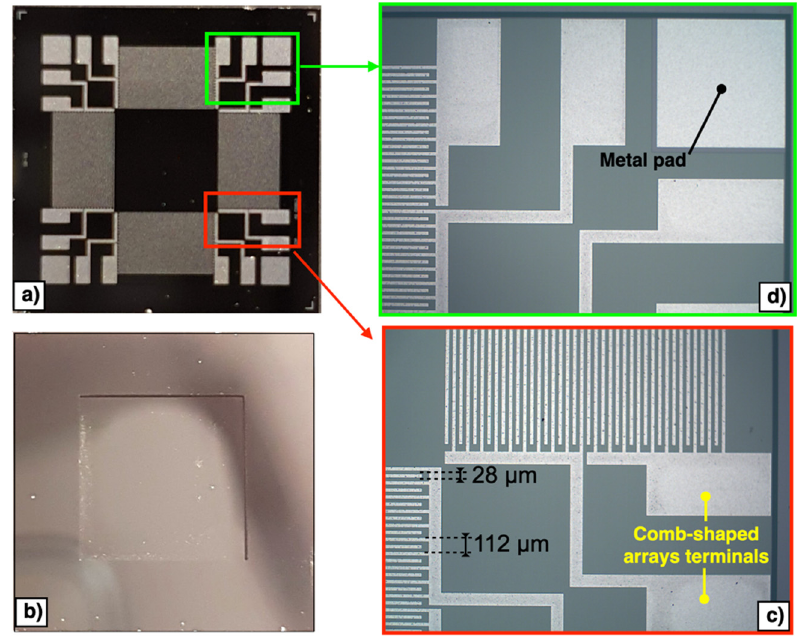
Figure 3. Top ( a ) and bottom ( b ) views of the fabricated piezoelectric MEMS device. Enlarged images of the comb-shaped arrays terminals ( c ) and metal pad ( d ).